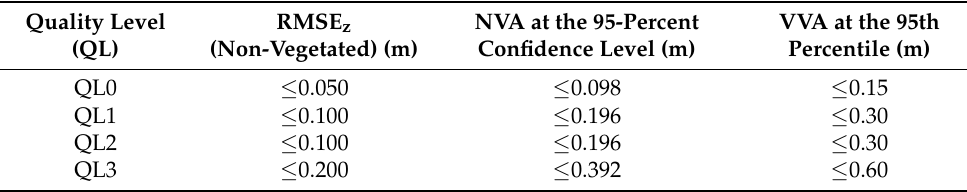
Table 1. Absolute vertical accuracy for light detection and ranging data and digital elevation models defined in the 3DEP Lidar Base Specification (NVA, non-vegetated vertical accuracy; VVA, vertical vegetated